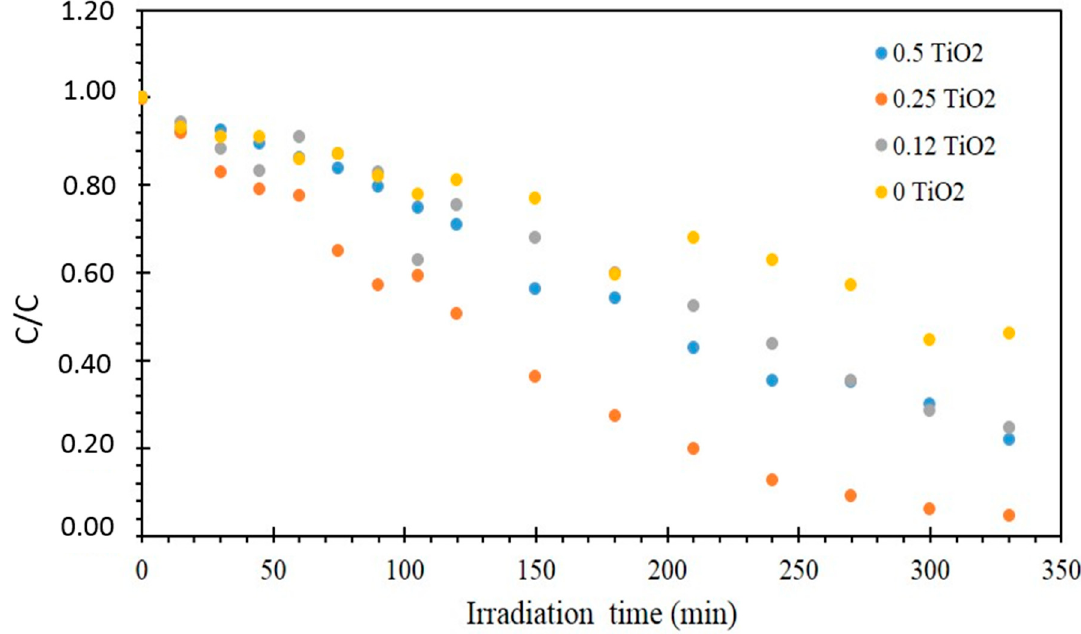
Figure 8. MB degradation using membranes with different amount of TiO 2 under UV irradiation.